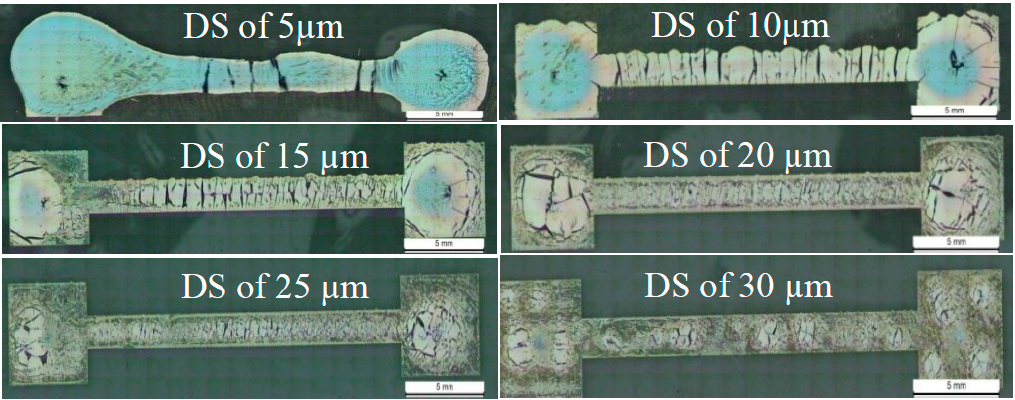
Figure 4. Optical microscope images of printed lines with DS of 5, 10, 15, 20, 25, and 30 µ m.